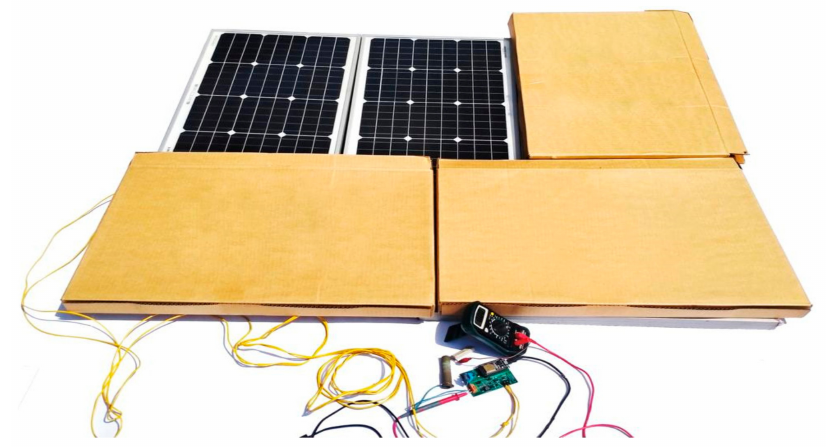
Figure 10. Two active PV modules.